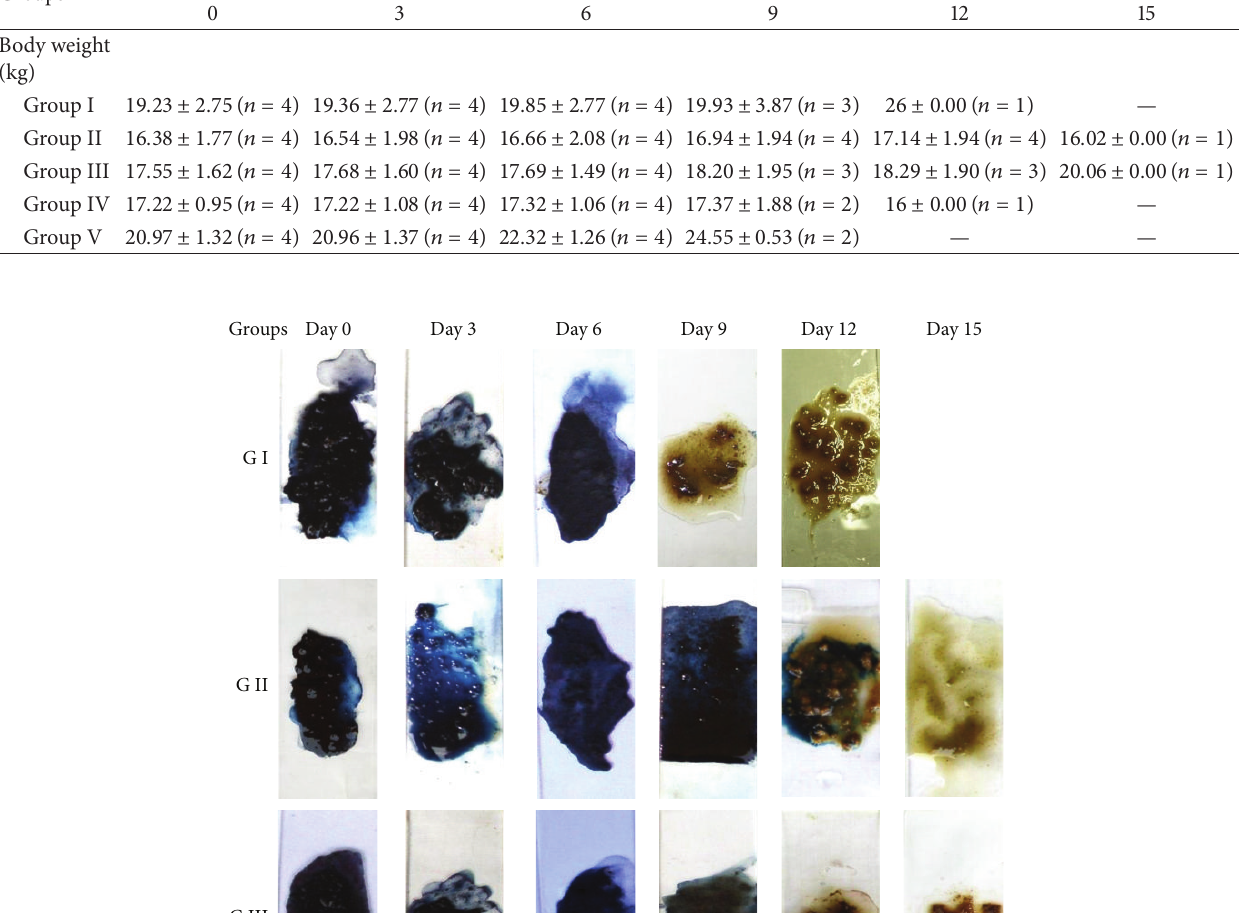
Table 4: Body weight in dogs in different groups at various intervals (mean ± S.E.). Groups